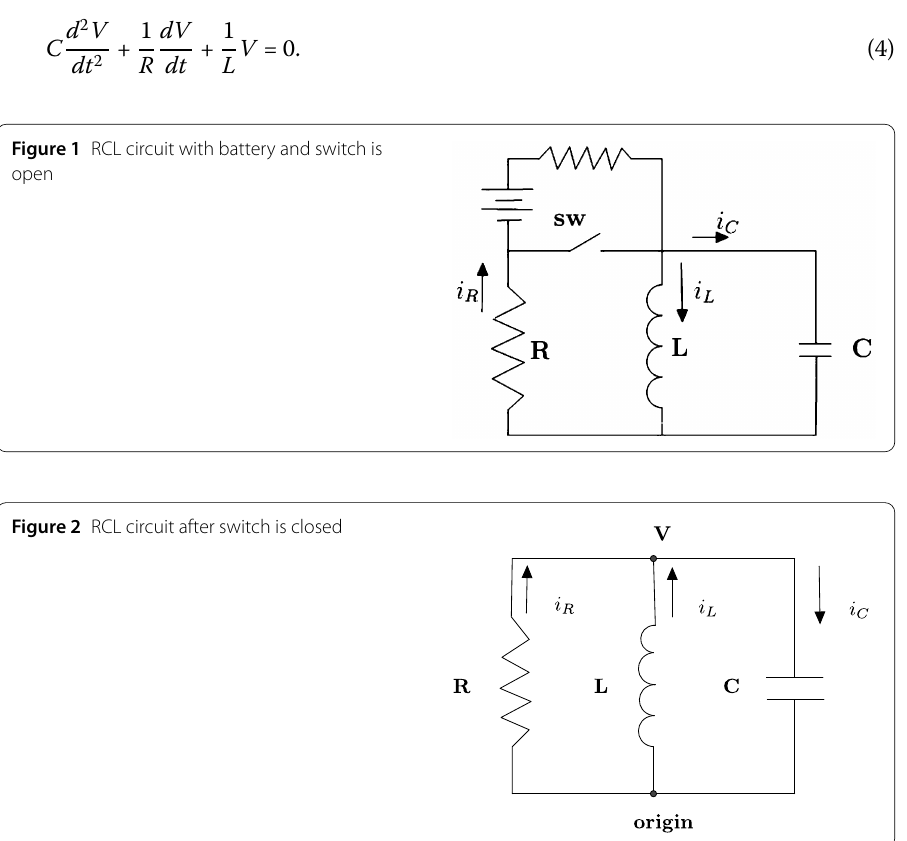
Figure 1 RCL circuit with battery and switch is open